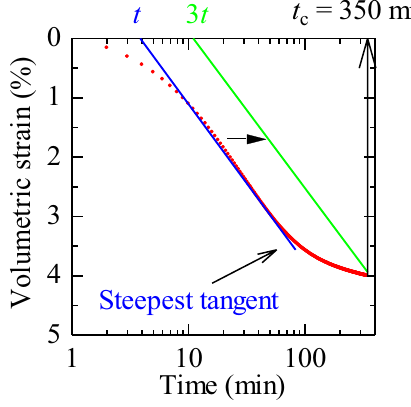
Fig. 13 Concept of 3 t -method to estimate the required consolida- tion time t c